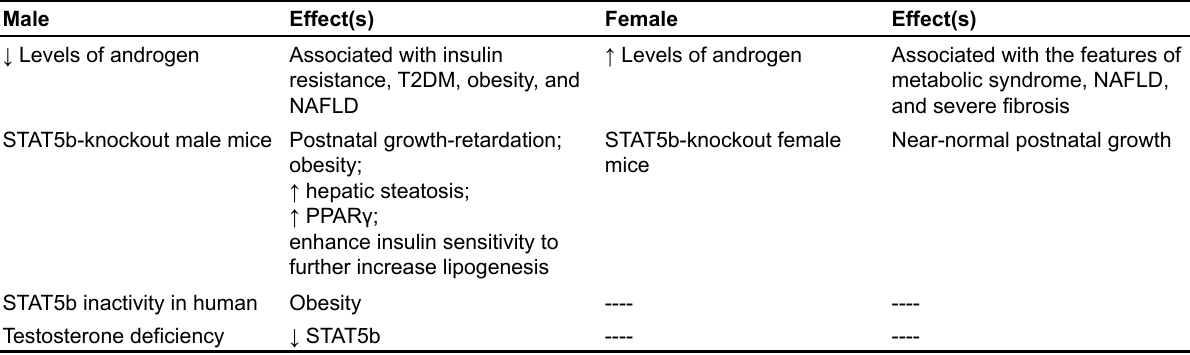
Table 3. Androgen and growth hormone-STAT5b axis role in sexual dimorphism of